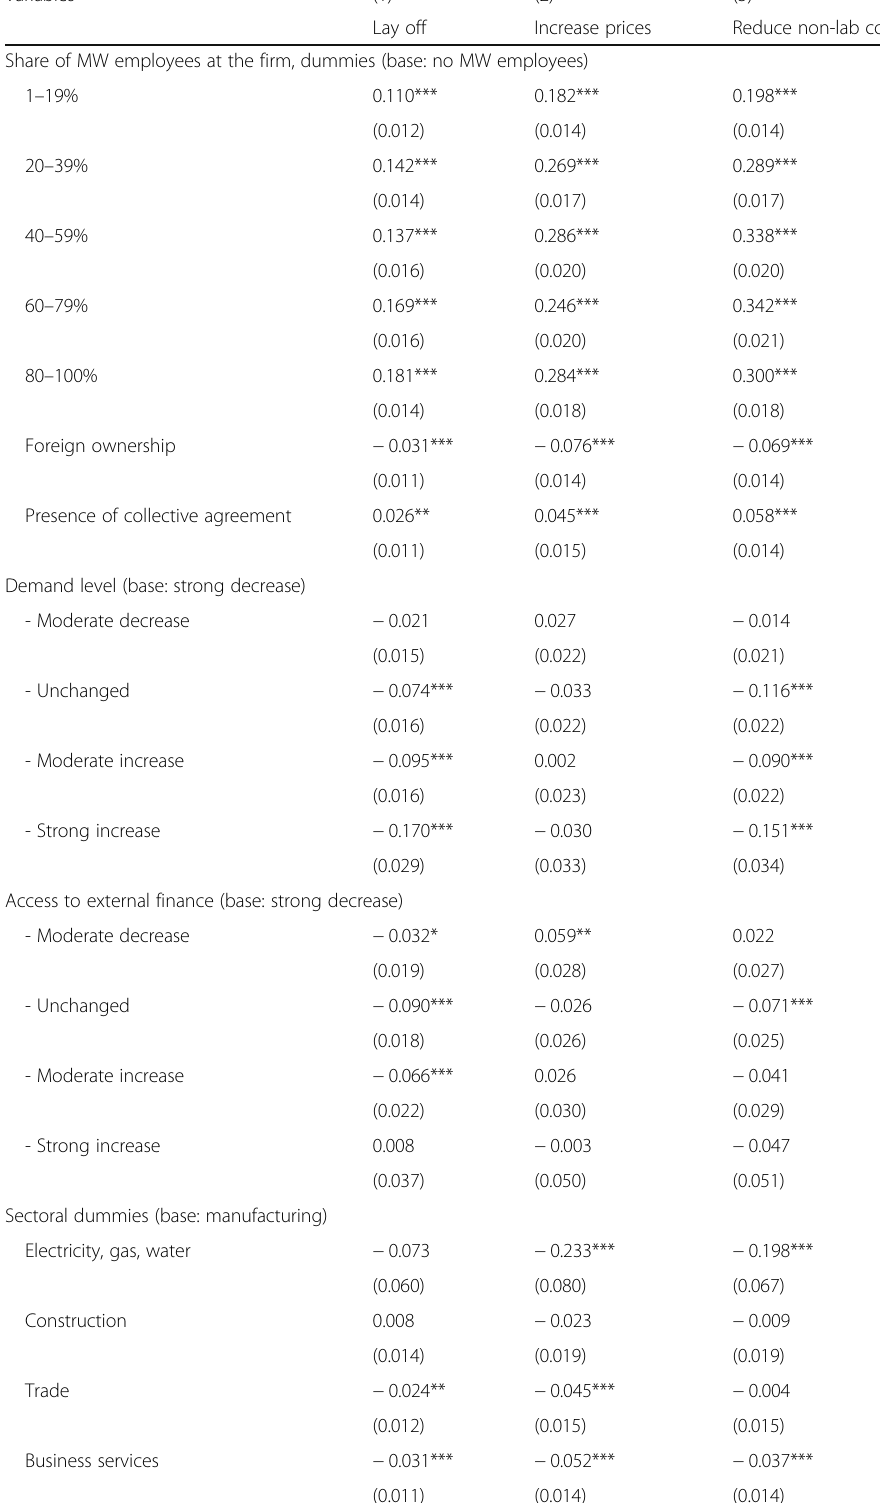
Table 13 Multivariate probit model of the relevance of adjustment channels, average marginal